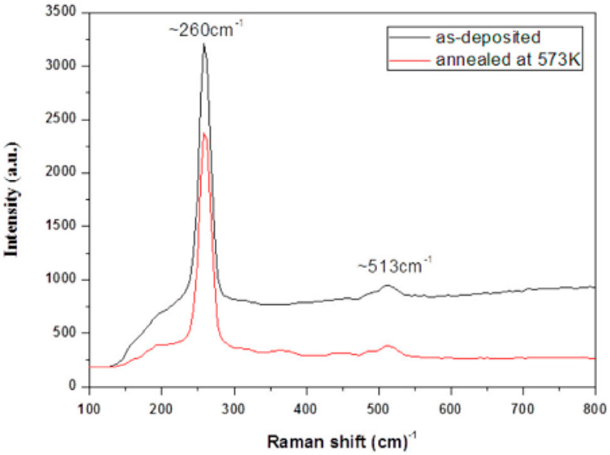
Figure 6. Raman spectra of as-deposited and annealed SILAR-deposited copper selenide films reproduced with permission from [113], Elsevier, 2016.